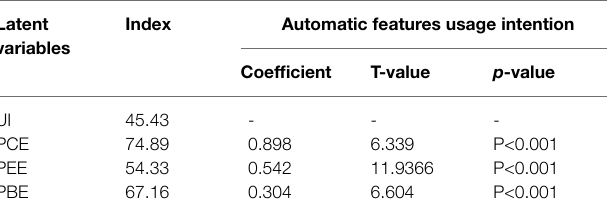
TABLE 9 | PLS path coefficient and